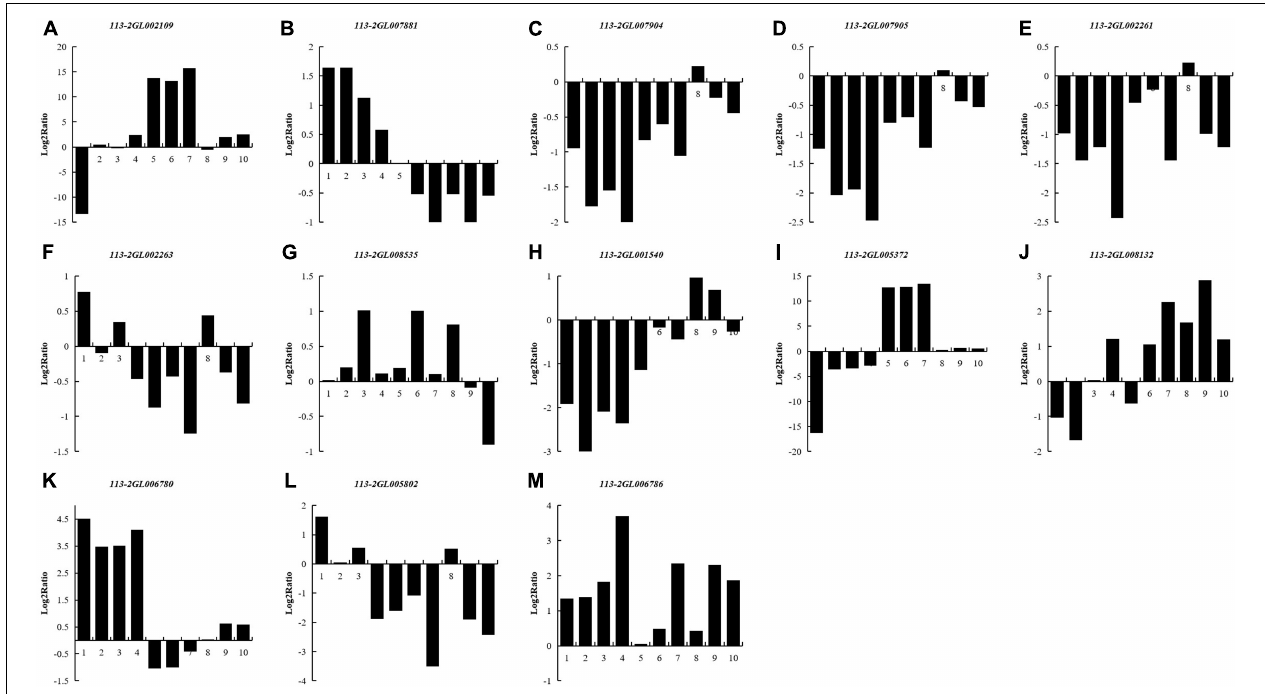
FIGURE 6 | List of the DEGs associated with three pathways between nodules from different developmental periods of soybean. Nitrogen metabolism (Ko00910) (A–D) : NirK (113-2GL002109), nifDKH (113-2GL007881, 113-2GL007904 and 113-2GL007905); ABC transporters (Ko02010) (E–J) : modC (113-2GL002261), modA (113-2GL002263), pstS (113-2GL008535), gltI, aatJ (113-2GL001540), lptG (113-2GL005372), urtA (113-2GL008132); Two-component system (Ko02020) (G,H,K–M) : pstS (113-2GL008535), gltI, aatJ (113-2GL001540), ccoN (113-2GL006780), atoB (113-2GL005802) and fixK (113-2GL006786). 1, branching stage vs. flowering stage; 2, branching stage vs. fruiting stage; 3, branching stage vs. pod stage; 4, branching stage vs. harvest stage; 5, flowering stage vs. fruiting stage; 6, flowering stage vs. pod stage; 7, flowering stage vs. harvest stage; 8, fruiting stage vs. pod stage; 9, fruiting stage vs. harvest stage; 10, pod stage vs. harvest stage.